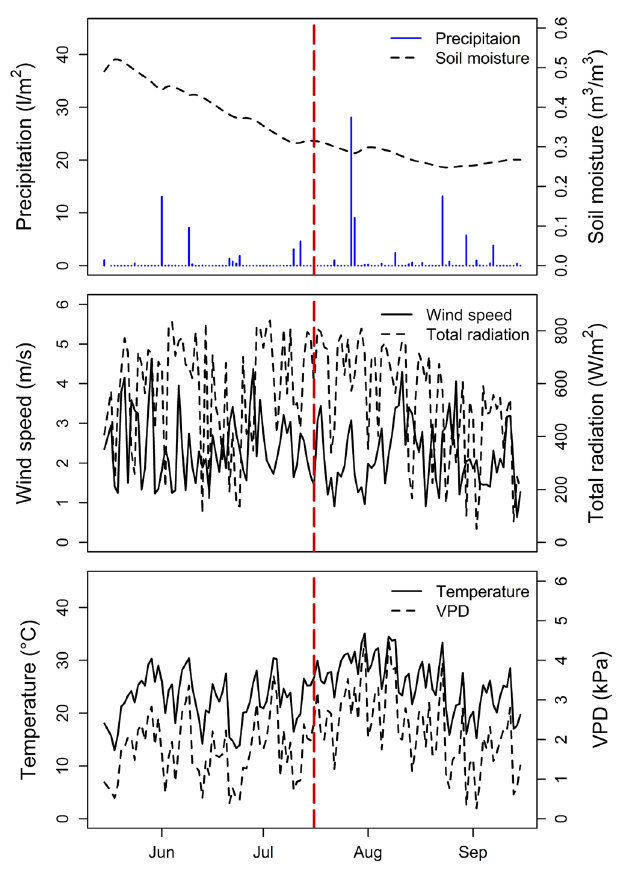
Figure 1. Daily midday (12:00–14:00 CET) average of total radiation, vapor pressure deficit (VPD), wind speed and soil moisture, as well as, total daily precipitation between May 15th and September 15th, 2018, dotted red line separates ‘moist’ and ‘dry’